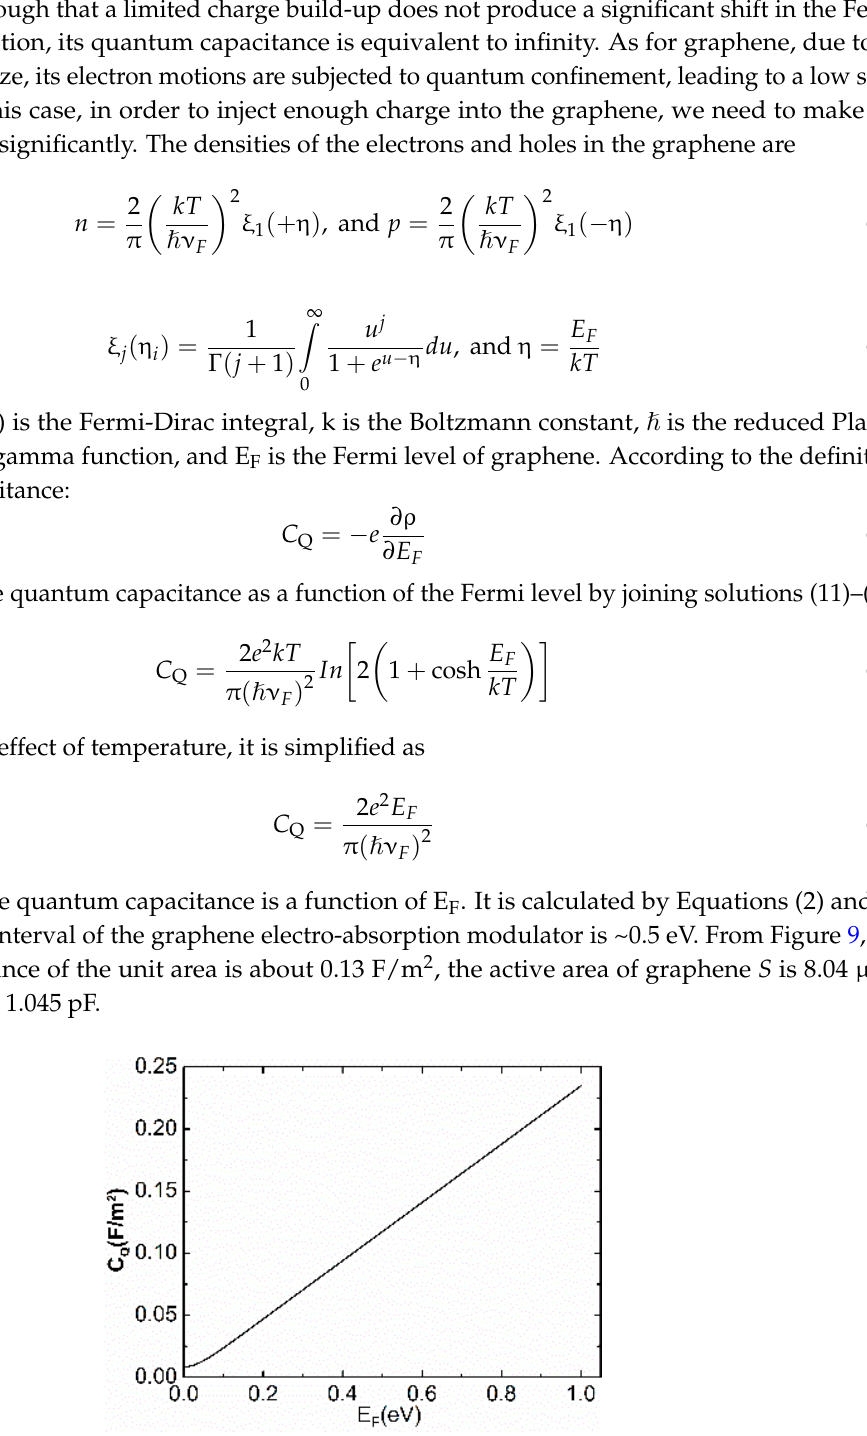
Figure 9. The curve of the graphene quantum capacitance with the Fermi level.